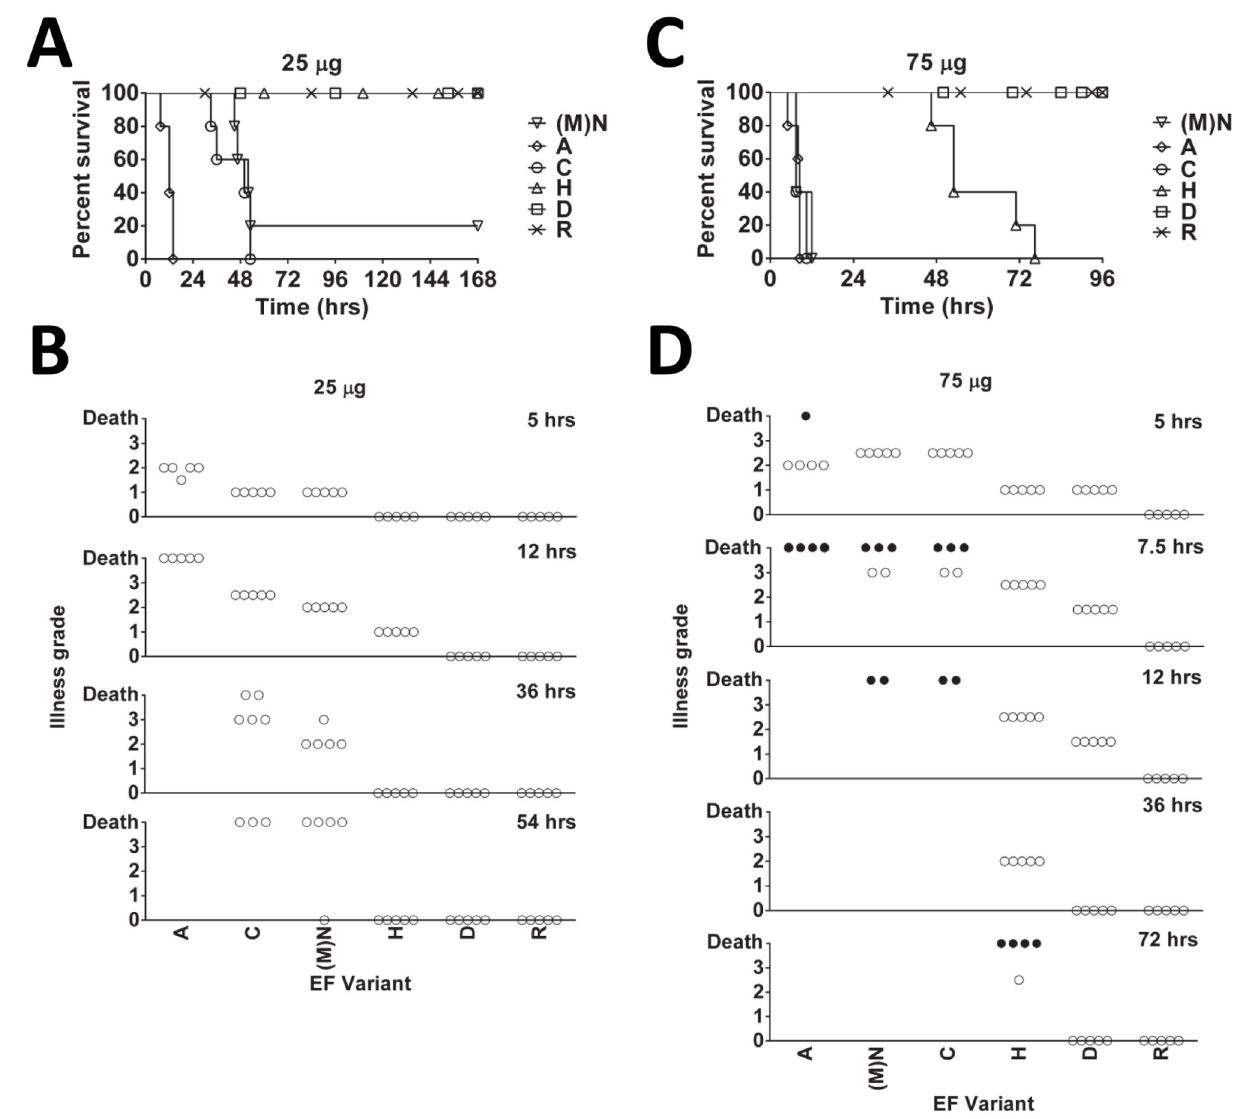
Figure 4. Effects of EF N-terminal variants on C57BL/6J mice. Kaplan-Meier survival curves (A, C) and malaise rating (B, D) for mice injected intravenously with 25 µg PA + 25 µg EF (A, B) or 75 µg PA + 75 µg EF (C, D). Open circles denote living mice, and black circles denote mouse death. Animals listed as dead at a given time point were removed from successive observations. doi: